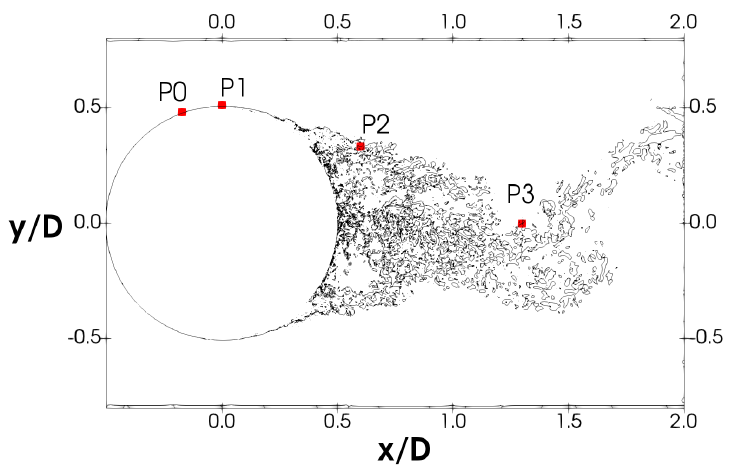
Figure 11. Location of the numerical